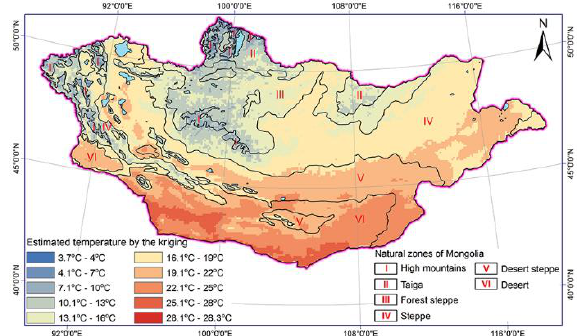
Figure 8. Station data, ERA5 model, IDW and Kriging calculated air temperature dynamics.